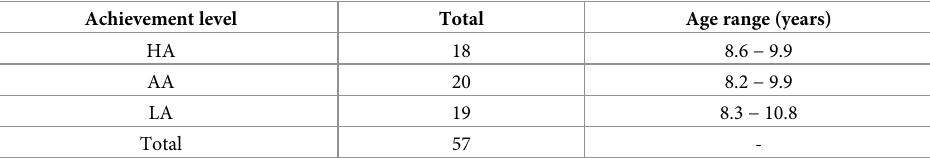
Table 1. Participant distribution by level of achievement and age